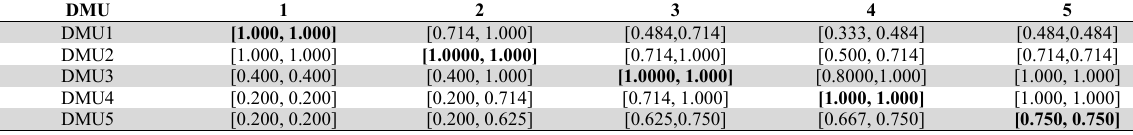
Cross-efficiency intervals matrix (CEIM) of performance assessment problem DMU 1 2